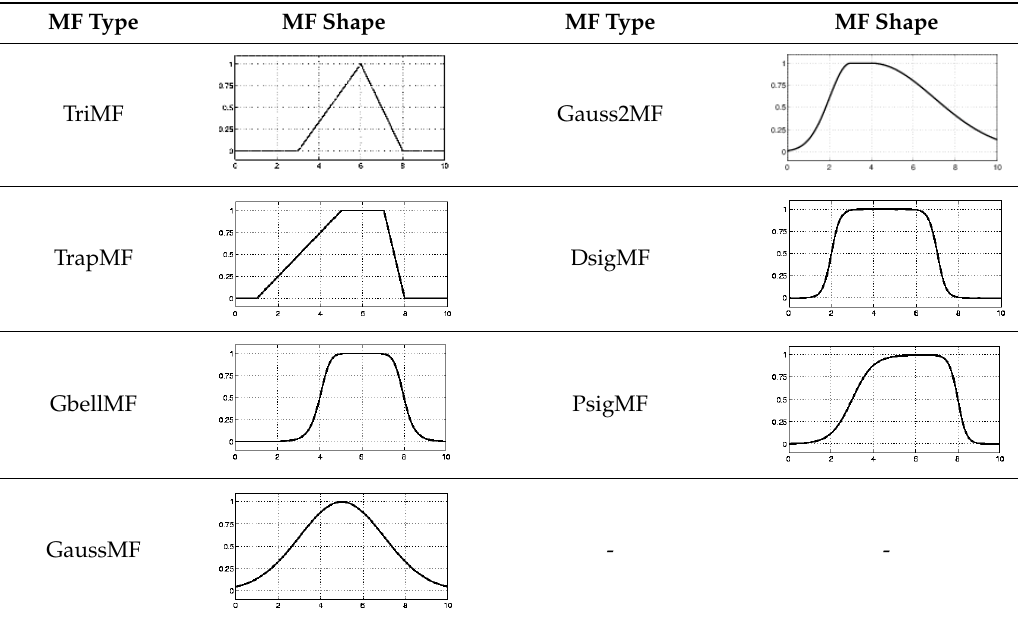
Table 9. Different MF types and shapes.